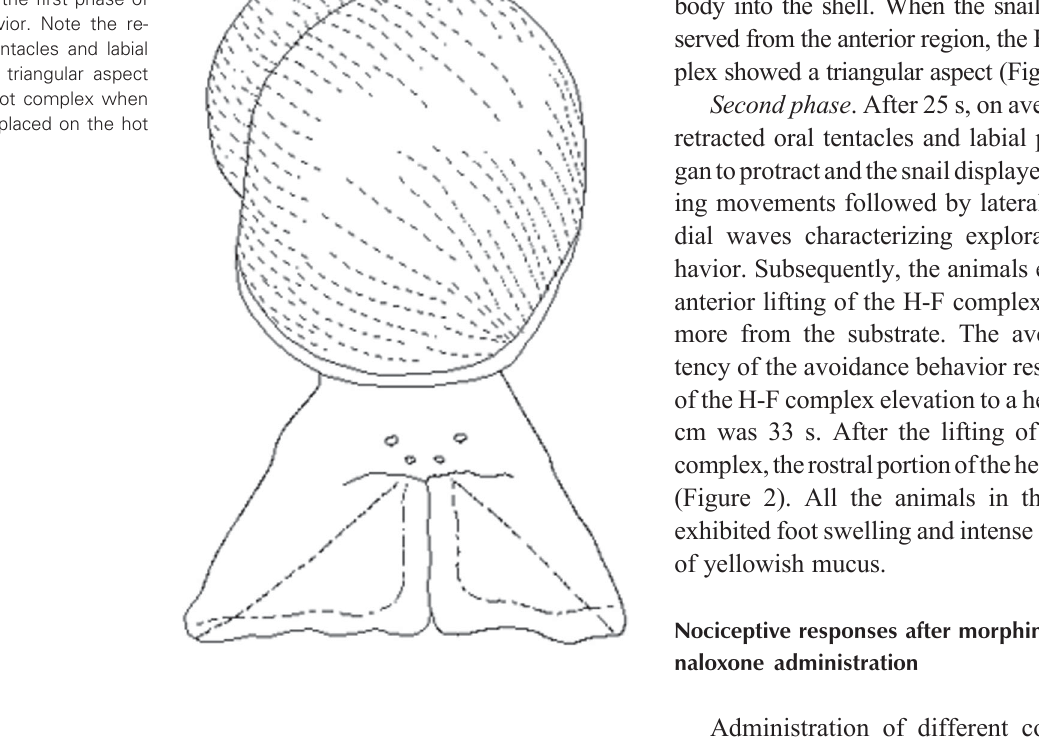
Figure 2. Schematic representa- tion of the second phase of the aversive behavior of the snail Megalobulimus abbreviatus . Note that, after protraction, the snail exhibited anterior lifting of the head-foot complex 1 cm from the substrate, characteriz- ing aversive